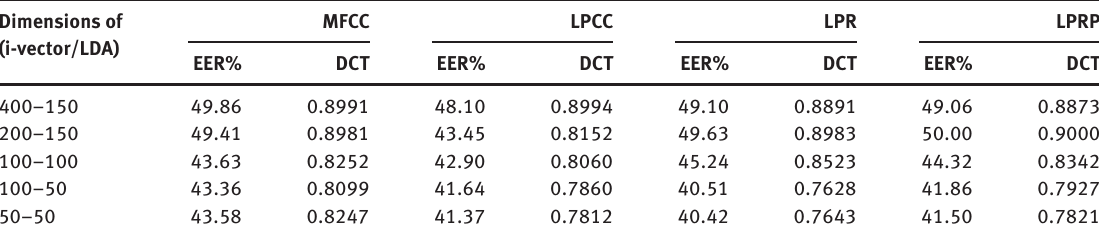
Table 1: EER of Speaker Verification for Different Dimensions of i-Vector and LDA Using the NIST 2003 Database for the 3–3 second Train/Test Data and Gaussian Mixture of 16, Features are MFCC, LPCC, LPR and LPRP (13